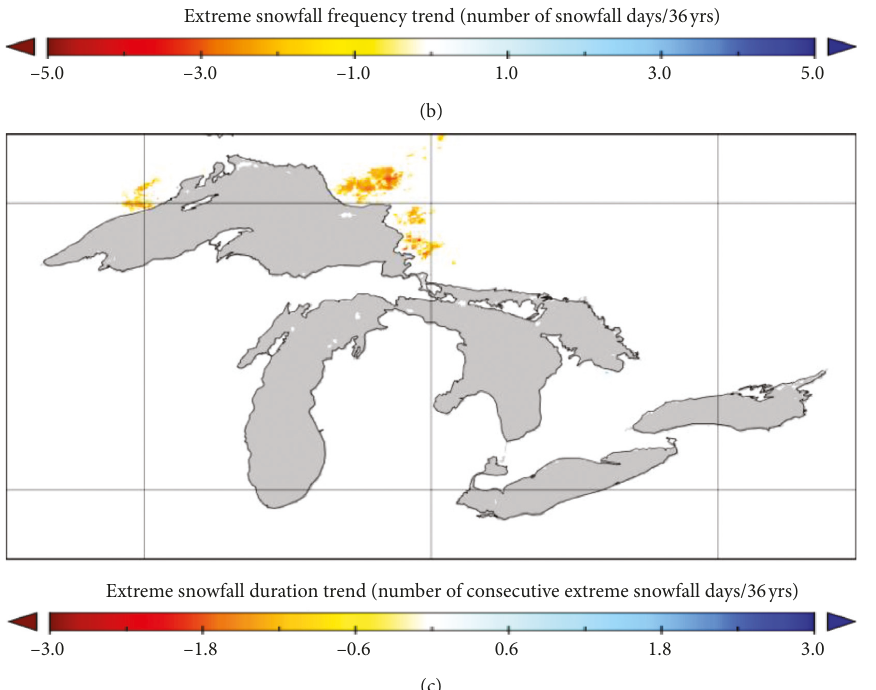
Figure 7: 1980 to 2015 trends in extreme snowfall (a) intensity, (b) frequency, and (c) duration, for the month of January. Gray pixels represent grid cells with no trend computed because region contains some years with no extreme snowfall